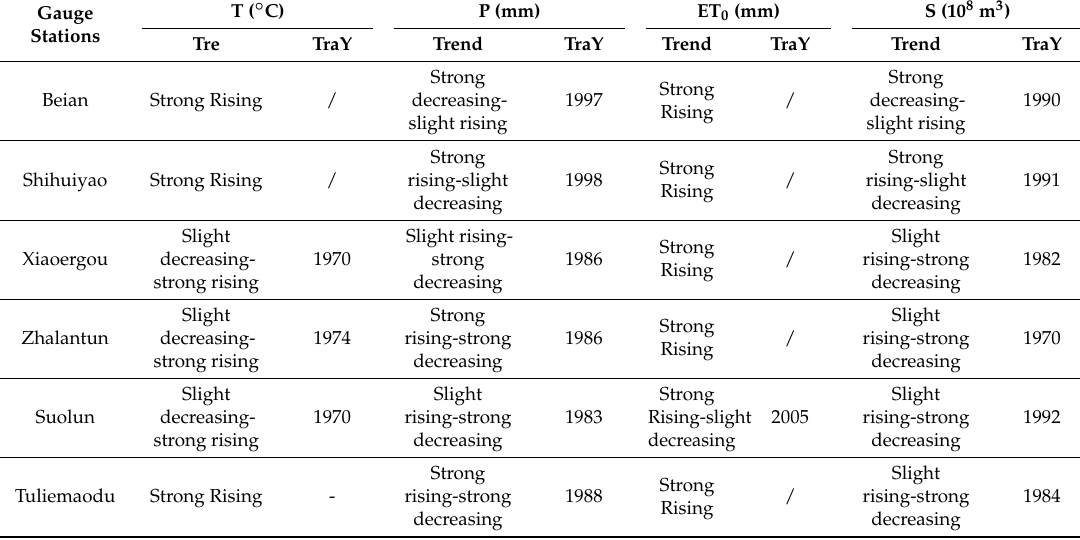
Strong rising- slight